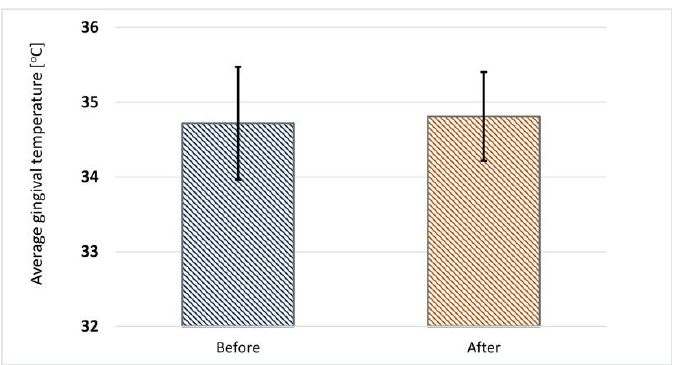
Figure 5. Box plot showing the difference in mean gingival temperature at the beginning of the test and at the end — before putting on the elastics and after 10 min of its acting.